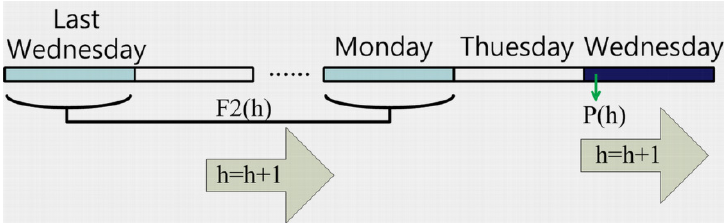
Figure 5. Moving data window (F2(h)) corresponding to forecasted